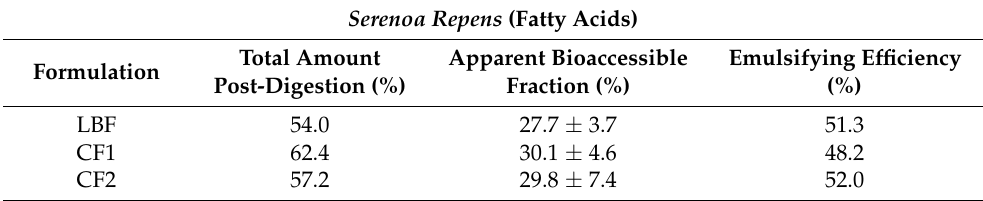
Table 3. Total amount and apparent bioaccessible fraction of SRO for the three tested formulations, expressed as a percentage of the total SRO in a single dose ( n =